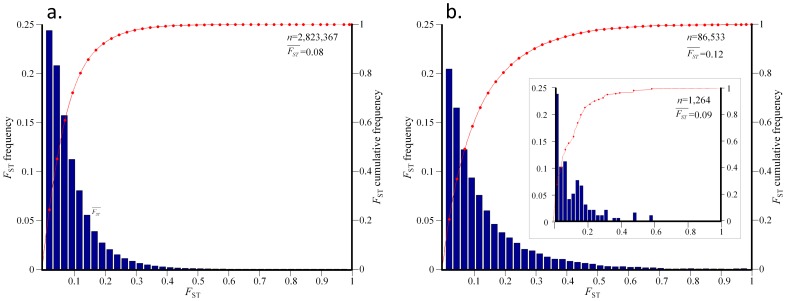
Distribution of locus-specific F
ST in three continental populations (CEU+TSI, CHB+CHD+JPT, LWK+MKK+YRI).
F
ST values were obtained for (a) 2,823,367 autosomal SNPs and (b) 86,533 SNPs on the non-recombining region of the X chromosome and 1,264 SNPs on the PAR region (inset). The histograms show bin distribution as indicated on the x-axis and the cumulative distribution (line).